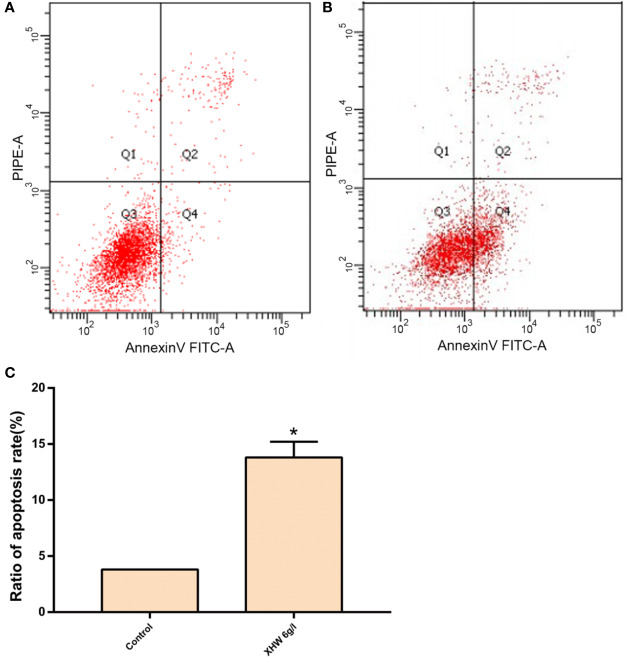
Effect of XHP on Apoptosis of MDA-MB-453 Cell. (A) apoptotic maps of a random set of three duplicate wells in the control group; (B) are apoptotic maps of a random set of three duplicate wells in the XHP group; (C) histogram of the proportion of apoptotic cells in the two groups, compared with the control group; *P < 0.05.